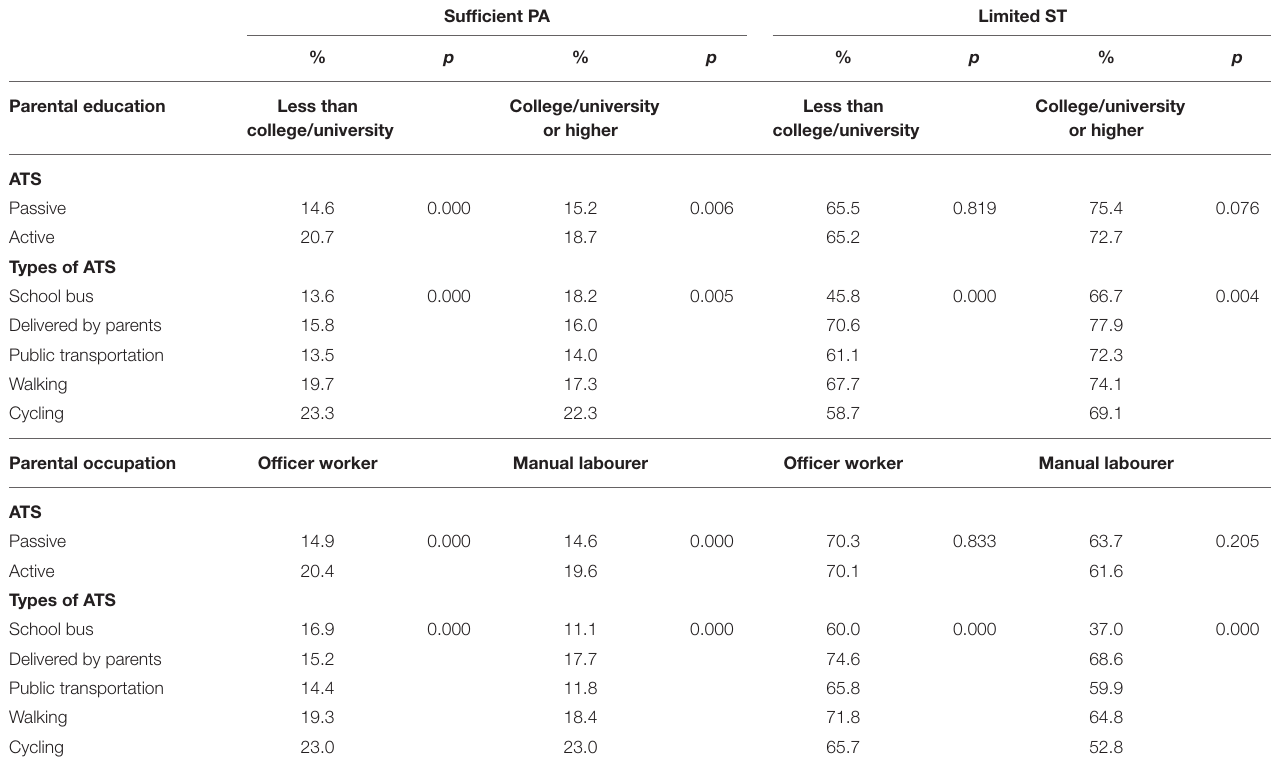
TABLE 4 | Difference of PA and ST by travel to school and its types as well as parental characteristics. Sufficient PA